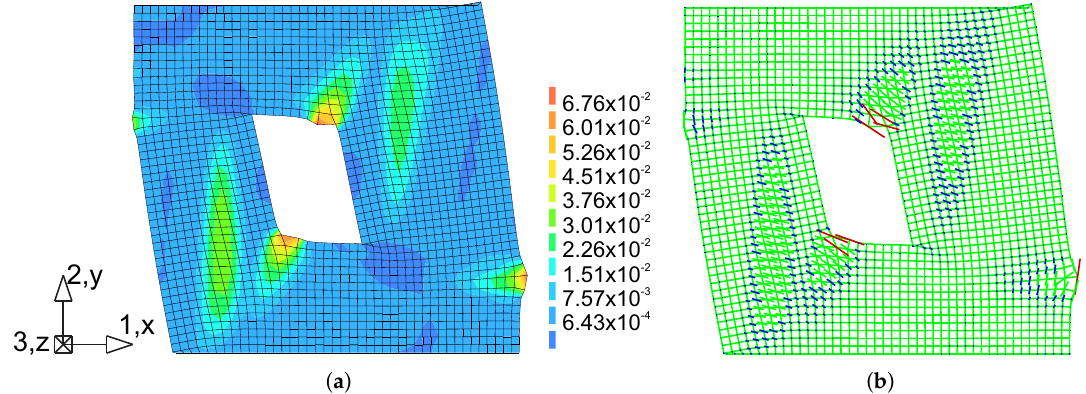
Figure 16. Maps of maximum principal plastic strain at ∆ = 12 mm: ( a ) crack (tensile) zones, ( b ) directions of the tensile strain.